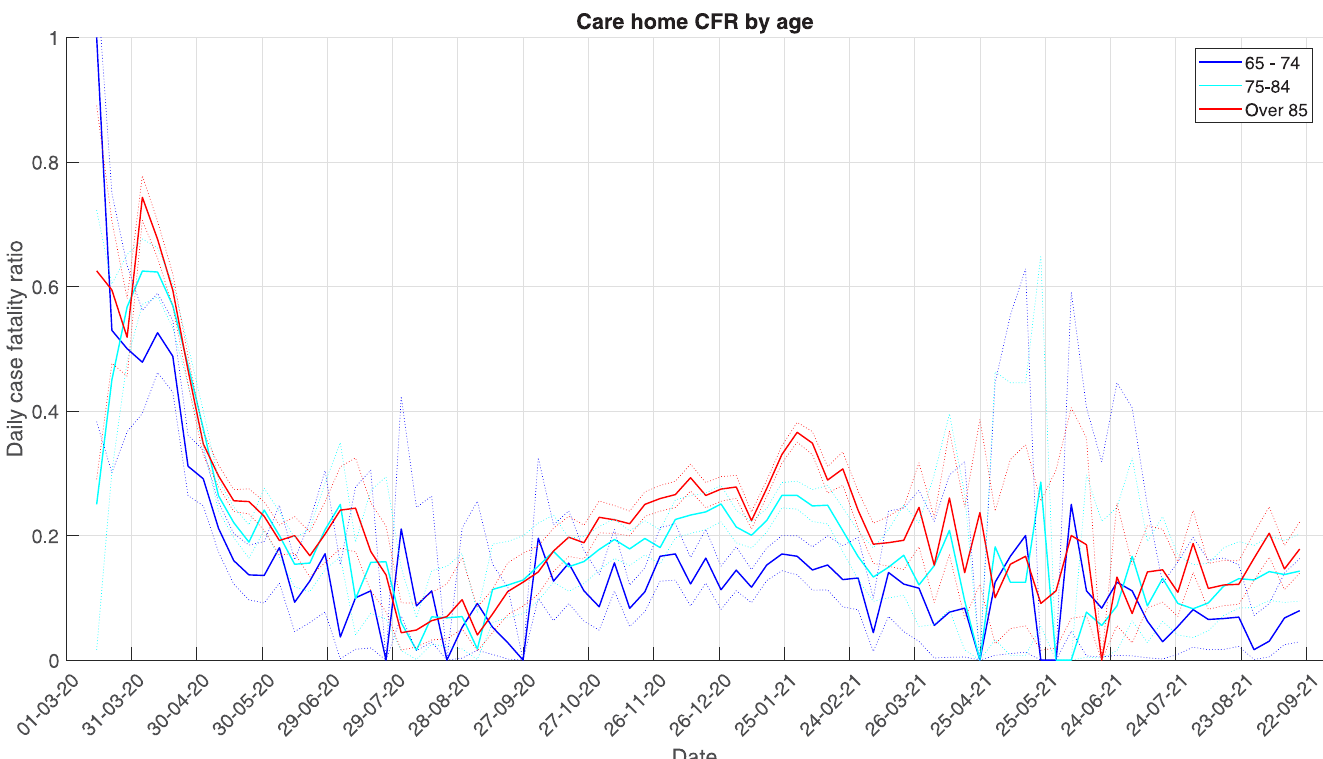
Fig 6. Comparing the CFR within different age groups of care home residents, using the weekly backward method and PHE data.